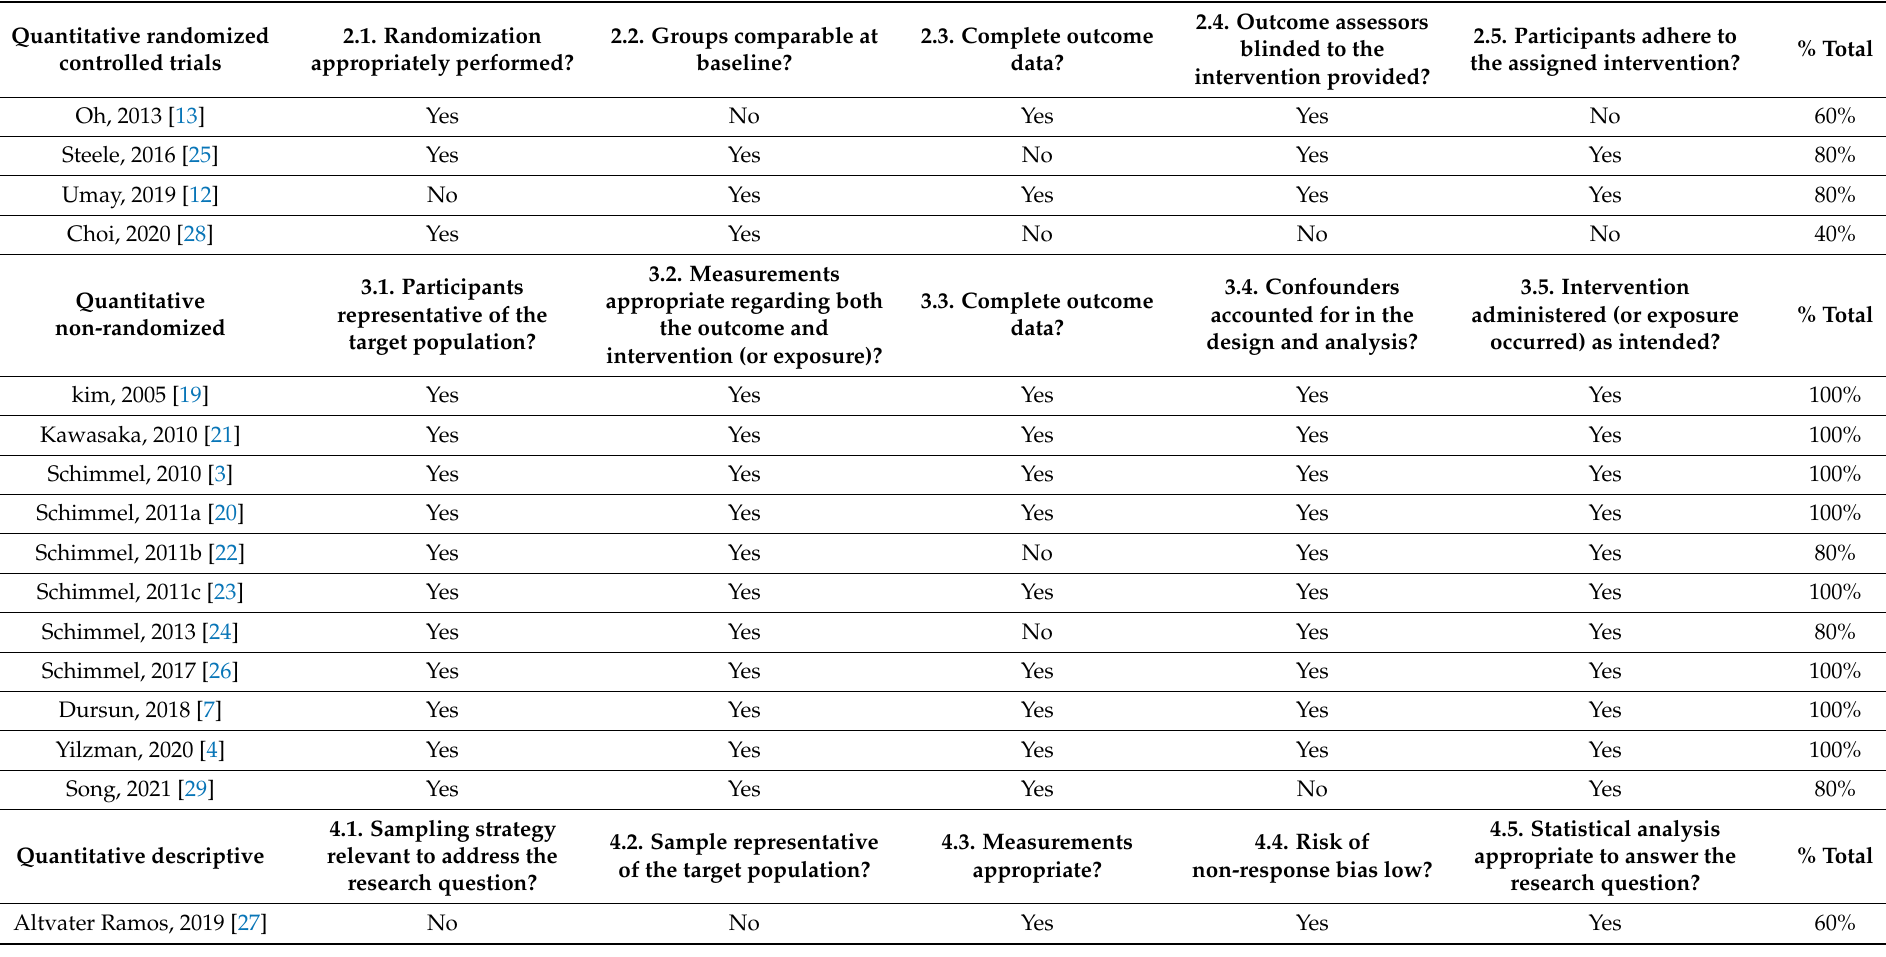
Table 3. Methodological